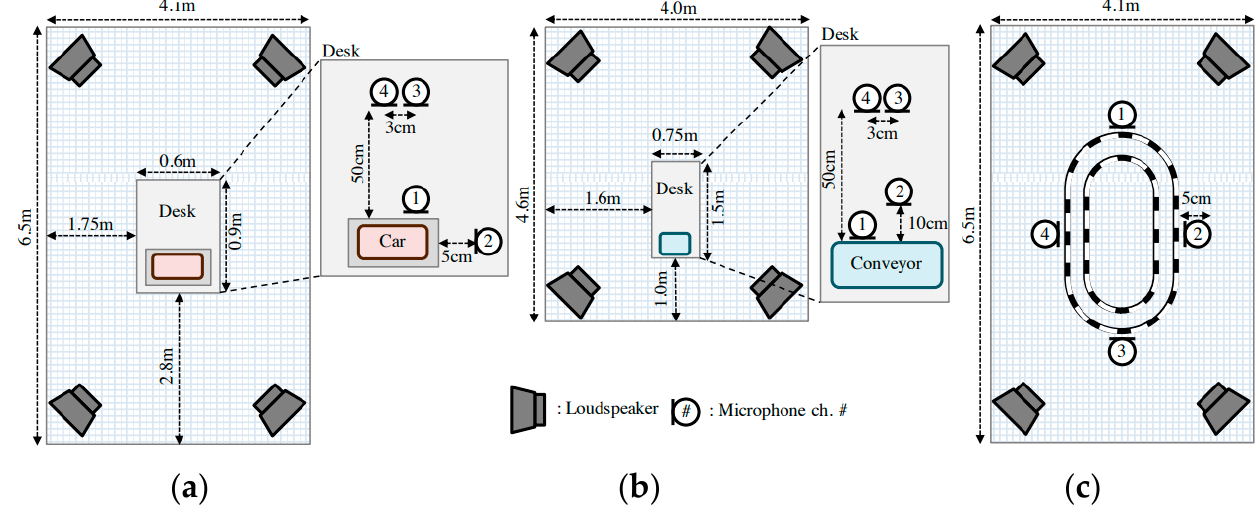
Figure 11. Schematic of ToyADMOS miniaturised machines ( a ) toy car ( b ) toy conveyor ( c ) toy train [9].